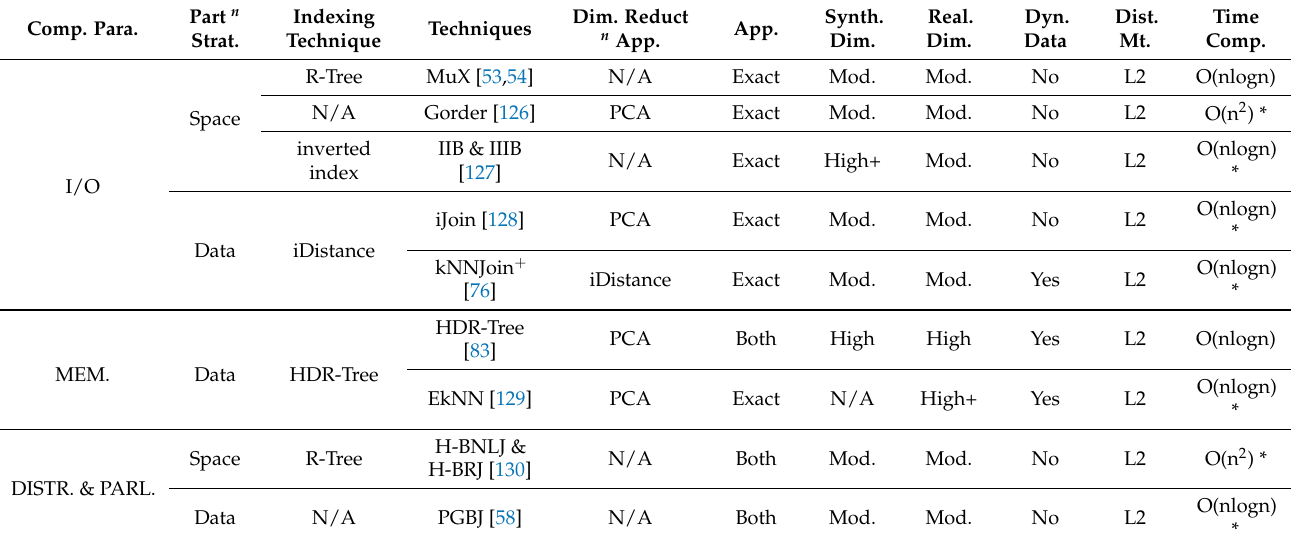
Table 4. Summary of kNN Join